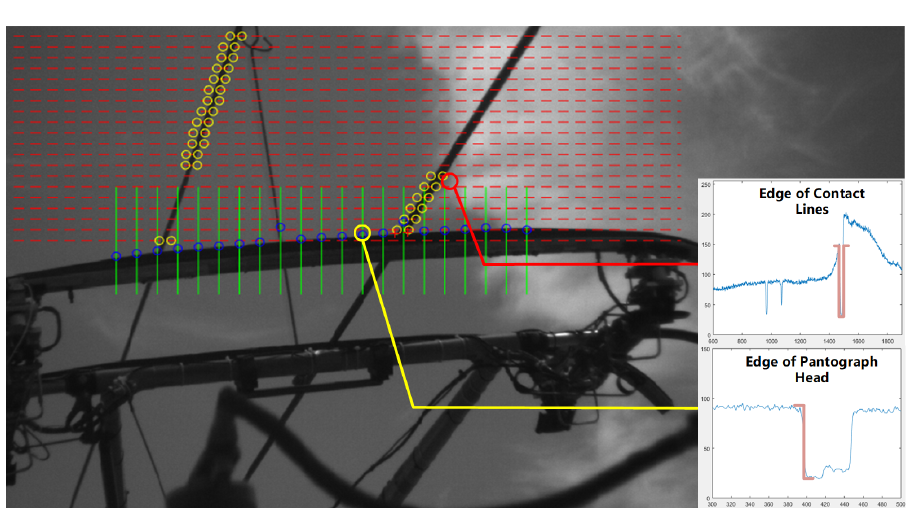
Figure 2. Contact points localization by template matching. Two template signals are shown in the bottom-right corner in bright